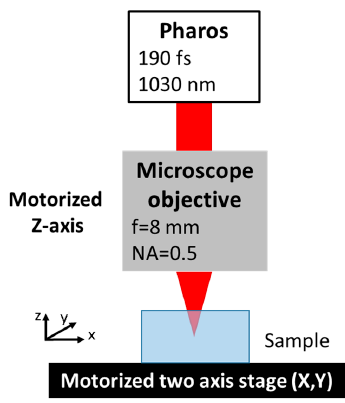
Figure 1. Experimental set ‐ up used for the cutting experiments.